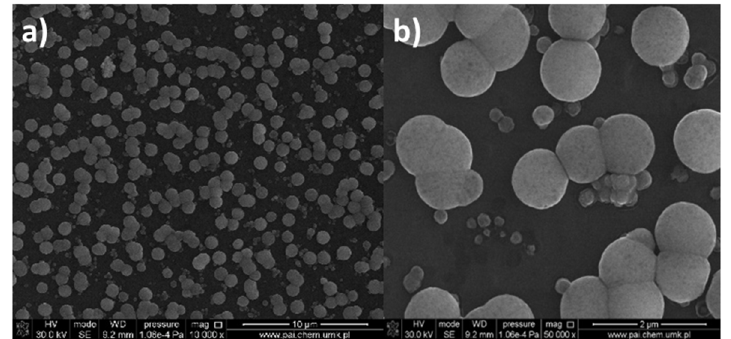
Figure 23. SEM images of [Cu 2 (EtNH 2 ) 2 (µ-O 2 CC 2 F 5 ) 4 ] ( 2 )/Si, after heating, ( a ) Mag = 10,000×, ( b ) Mag 50,000× .